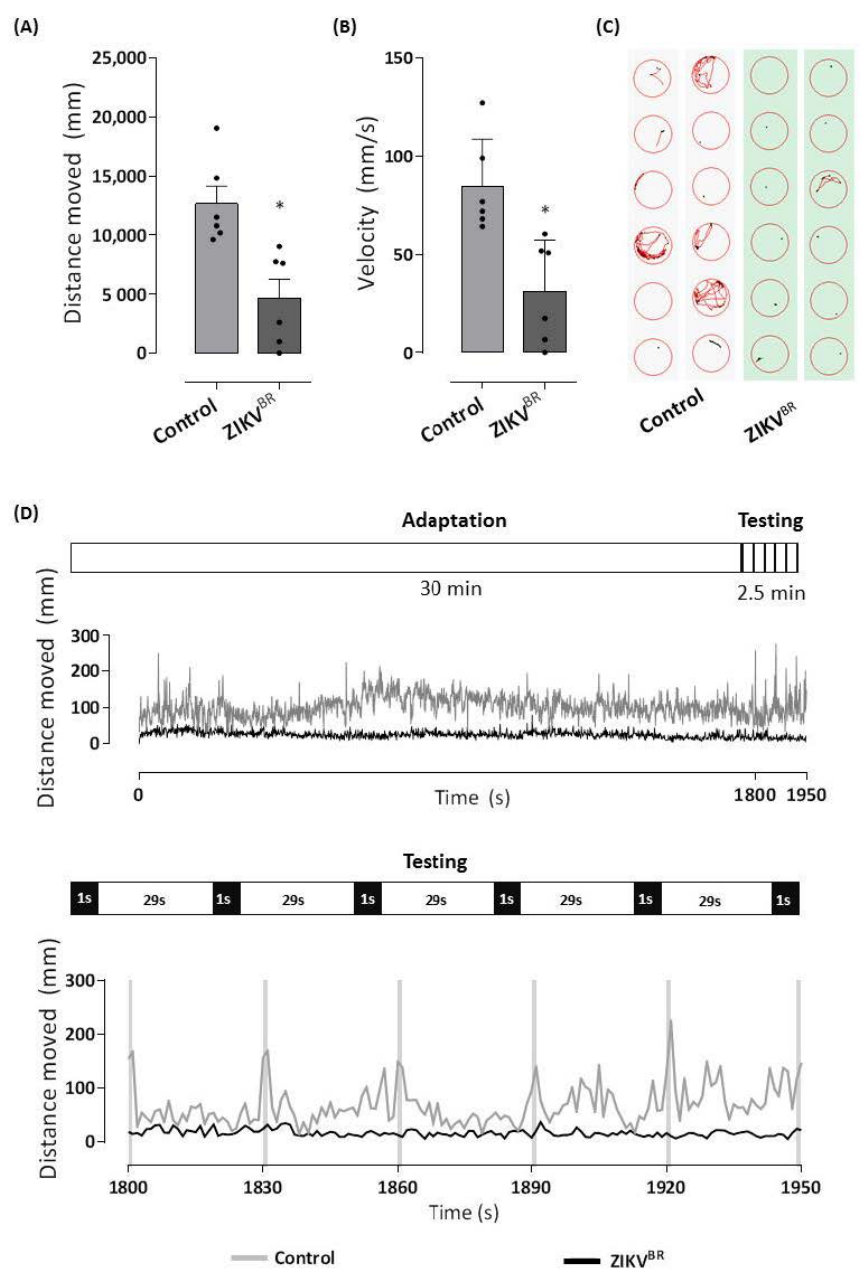
Figure 2. ZIKV infection of one-cell stage embryo changes locomotor activity behavior. The 96 hpf larvae infected with ZIKV BR at 0 hpf or control group were distributed in a 96-well plate (1 larva/well), and the locomotor activity was analyzed in Zebrabox system. The larvae were exposed to an incubation period of 30 min in the light (lux: 12%) followed by the testing phase consisting of a dark stimulus (lux: 0%) for 1s, alternated by 29s in the light (lux: 12%) for 2.5 min to induce visual stimulation and the startle response. The total distance moved (mm) by each group during the testing period ( A ) and the average velocity of each group in mm/s are shown in ( B ). Graphical representation of larvae tracking during the testing phase ( C ). The lines represent the distance moved by the larvae at each second during the total experiment period with highlights of testing phase ( D ). Each bar represents the mean ± SEM. * p < 0.05 compared with the negative control group.